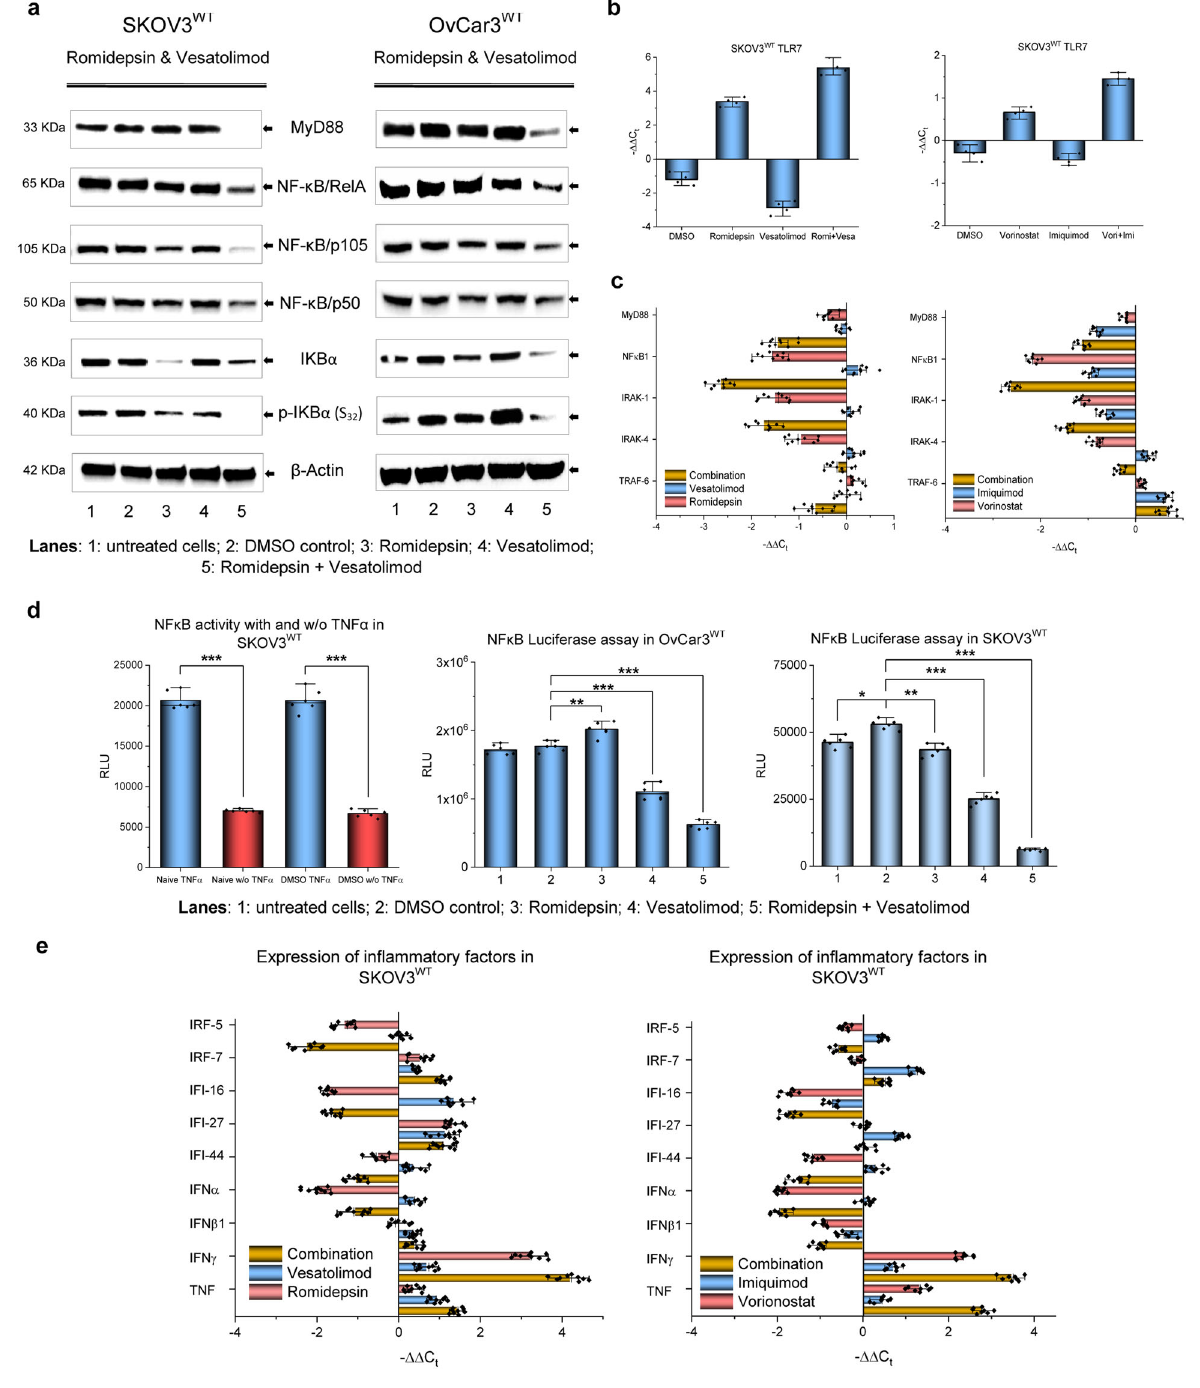
Fig. 6 In fl uence of HDACi and TLR7a on TRL7 signalling in OC cells. a HTCT affects signalling downstream of TLR7 up to the last effector, i.e. NF κ B, in the OC cell lines SKOV3 WT and OvCar3 WT . MyD88 and NF κ B protein synthesis is selectively repressed. Note the hypophosphorylation of the kinase IKB α , which is responsible for the degradation of the transcription factor NF κ B. b In fl uence of HDACis, TLR7/8as and their combination on TLR7 transcripts in SKOV3 WT cells (qPCR). The combination treatment upregulates TLR7 transcripts. c Effect of HTCT on TLR7 signalling at the mRNA level in SKOV3 WT cells. d Reduced hypophosphorylation of p105 after drug incubation inactivates NF κ B, determined using the NanoLuc ® assay containing a consensus for NF κ B and stimulating both cell lines with TNF α to amplify the system signals. * p < 0.05, ** p < 0.01, *** p < 0.001 (paired Student ’ s t test; two-tailed). e Impact on in fl ammatory signalling: transcript levels of a panel of in fl ammatory mediators in SKOV3 WT differed when treated with single drugs, but were very similar to HTCT. In contrast, both IFN ɣ and TNF α were signi fi cantly upregulated. Results are representative of n ≥ 3 experiments.